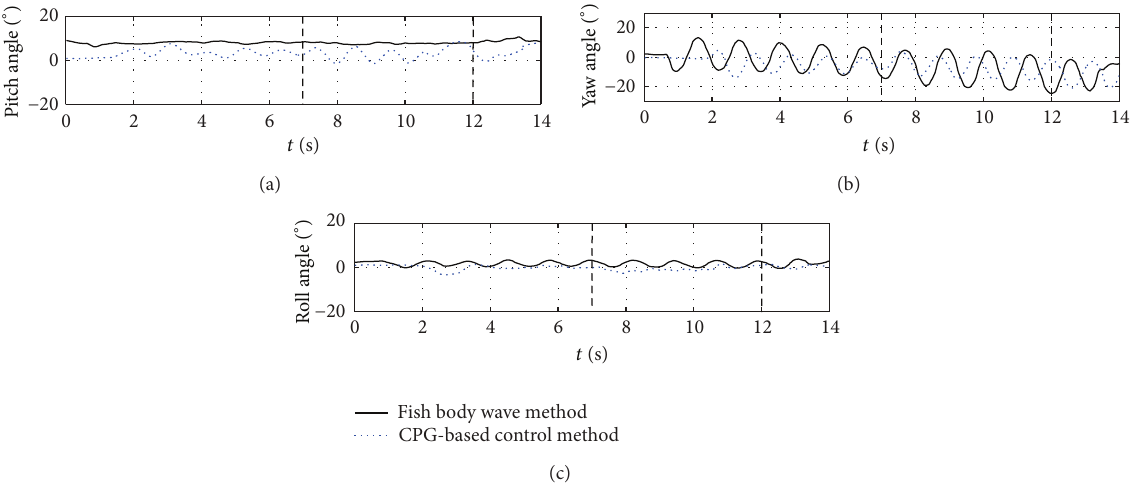
Figure 10: Stability comparison of the CPG-based control method against the fish body wave method in the BCF-type swimming.